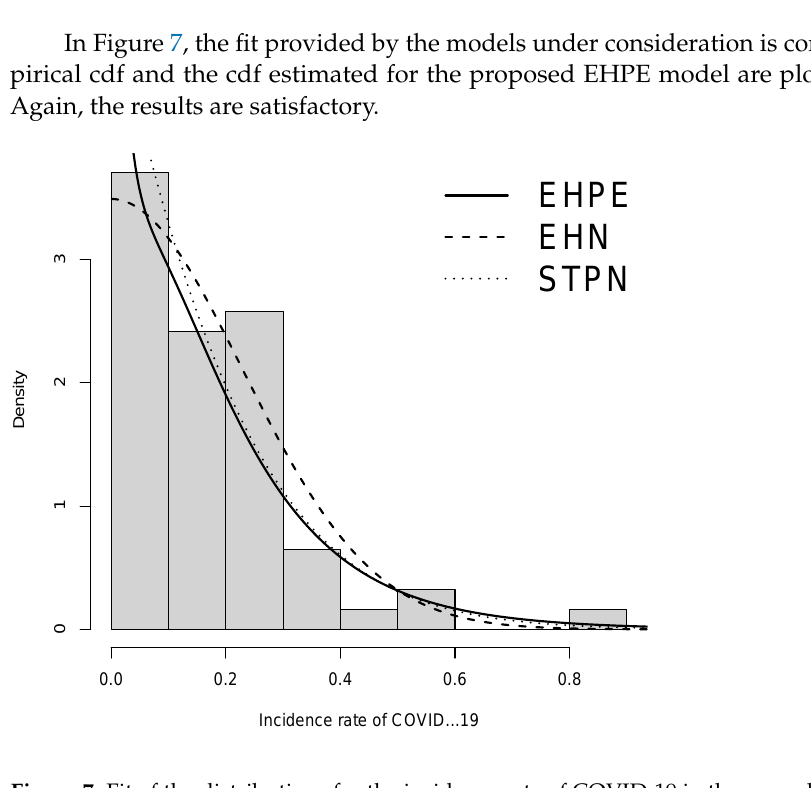
Figure 7. Fit of the distributions for the incidence rate of COVID-19 in the second data